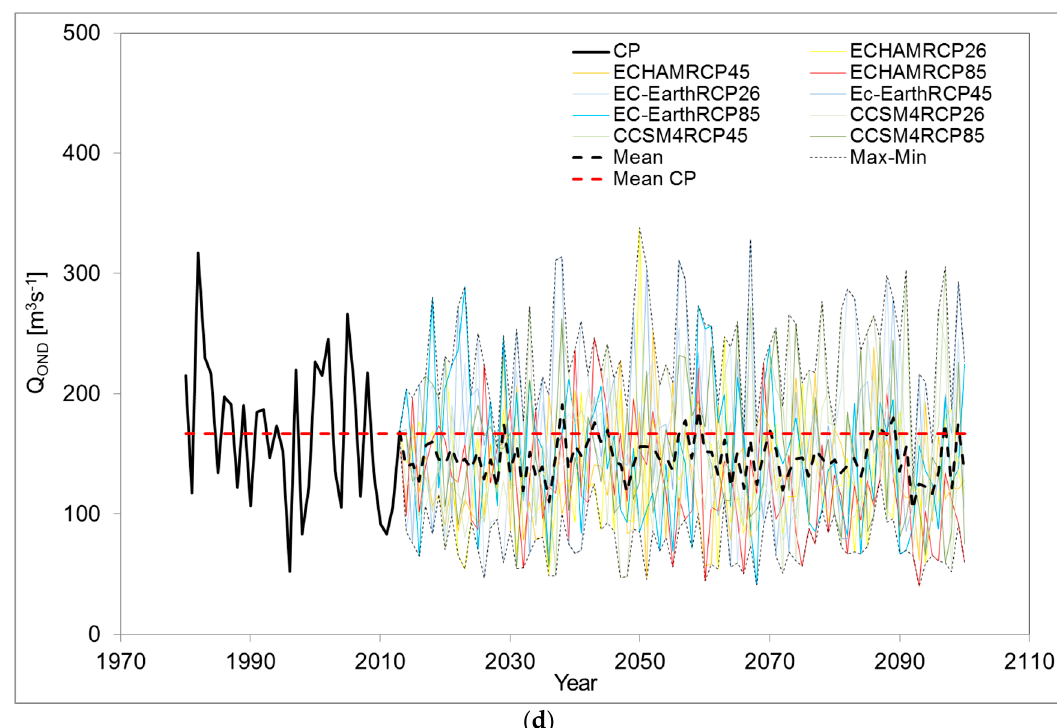
Figure 5. Rio Maipo at El Manzano. Stream flow projections until 2100 vs. CP (1980–2014). ( a ) Summer JFM. ( b ) Fall AMJ. ( c ) Winter JAS. ( d ) Spring OND.